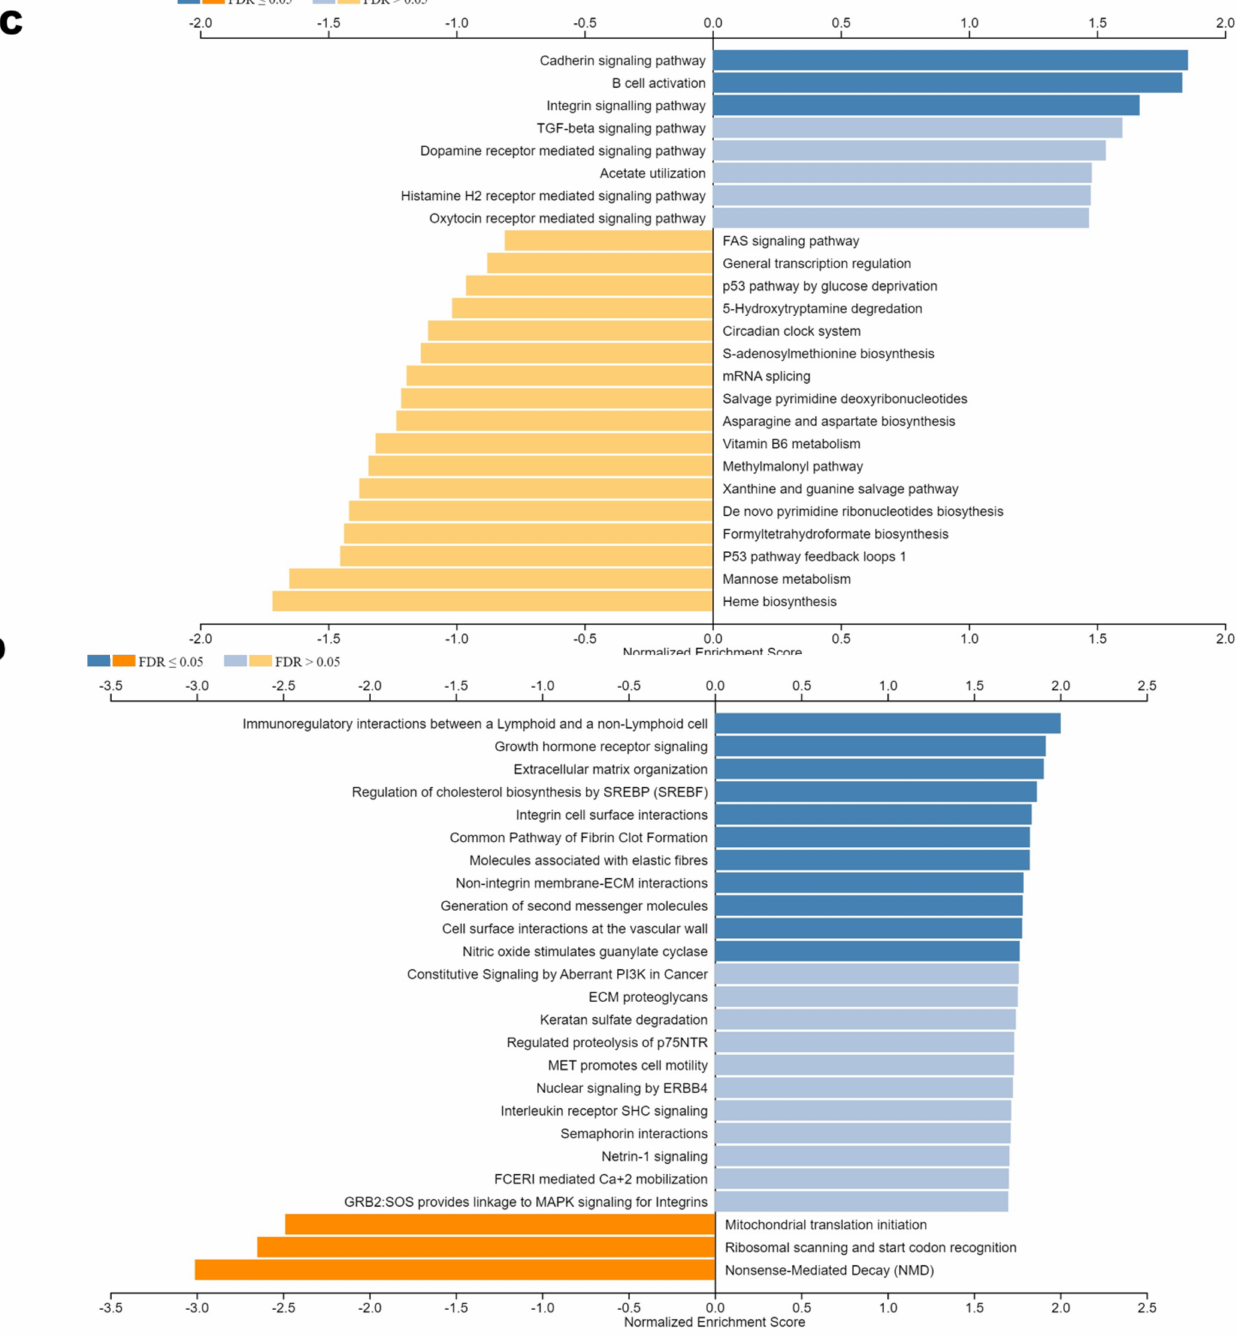
Figure 5. Enriched GO functions and KEGG pathways of ST8SIA6 in colon cancer. The identified differentially expressed genes with ST8SIA6 in colon cancer were explored from LinkedOmics for GO and KEGG pathway analyses. ( A ) GO term annotation of ST8SIA6 and co-expressed genes by gene set enrichment analysis (GSEA). ( B – D ) KEGG pathway-related Panther or Reactome analysis showed the enrichment pathway related ST8SIA6 and co-expressed